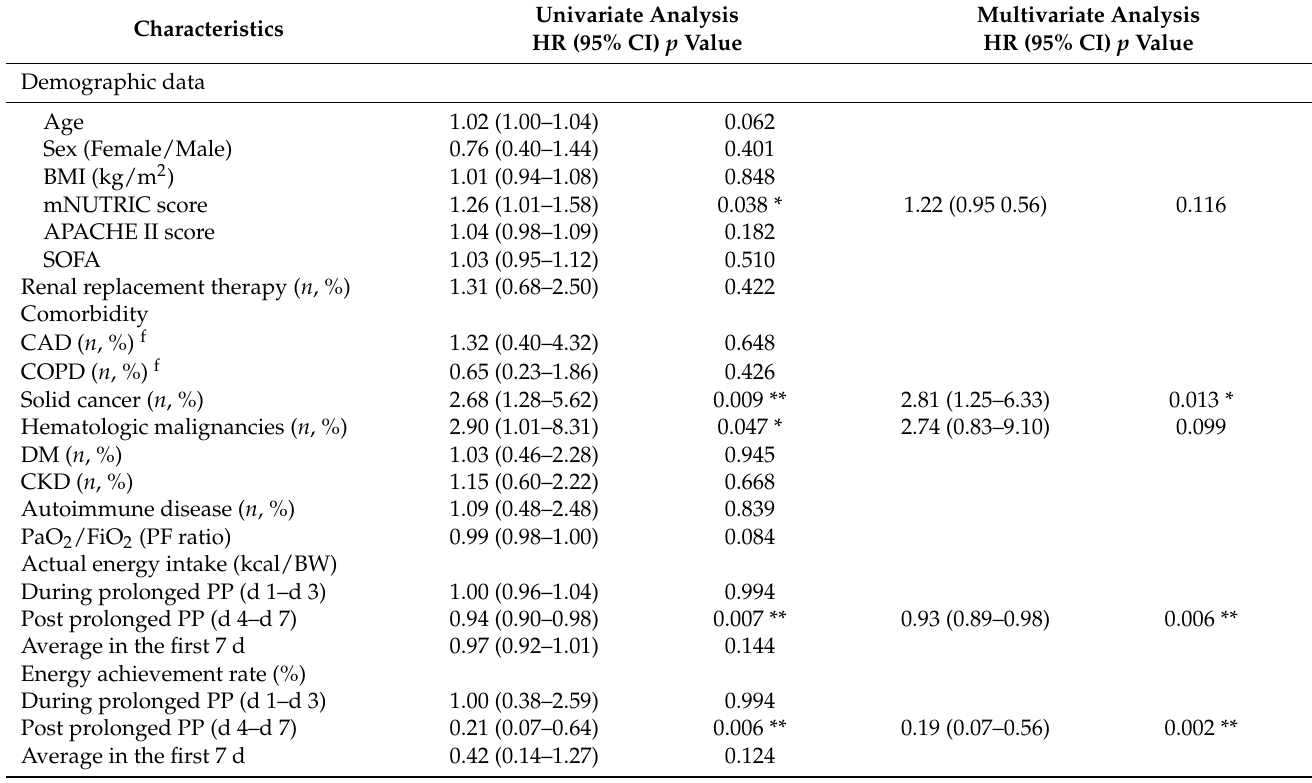
Table 3. Univariate and multivariate analyses of factors associated with ICU mortality.